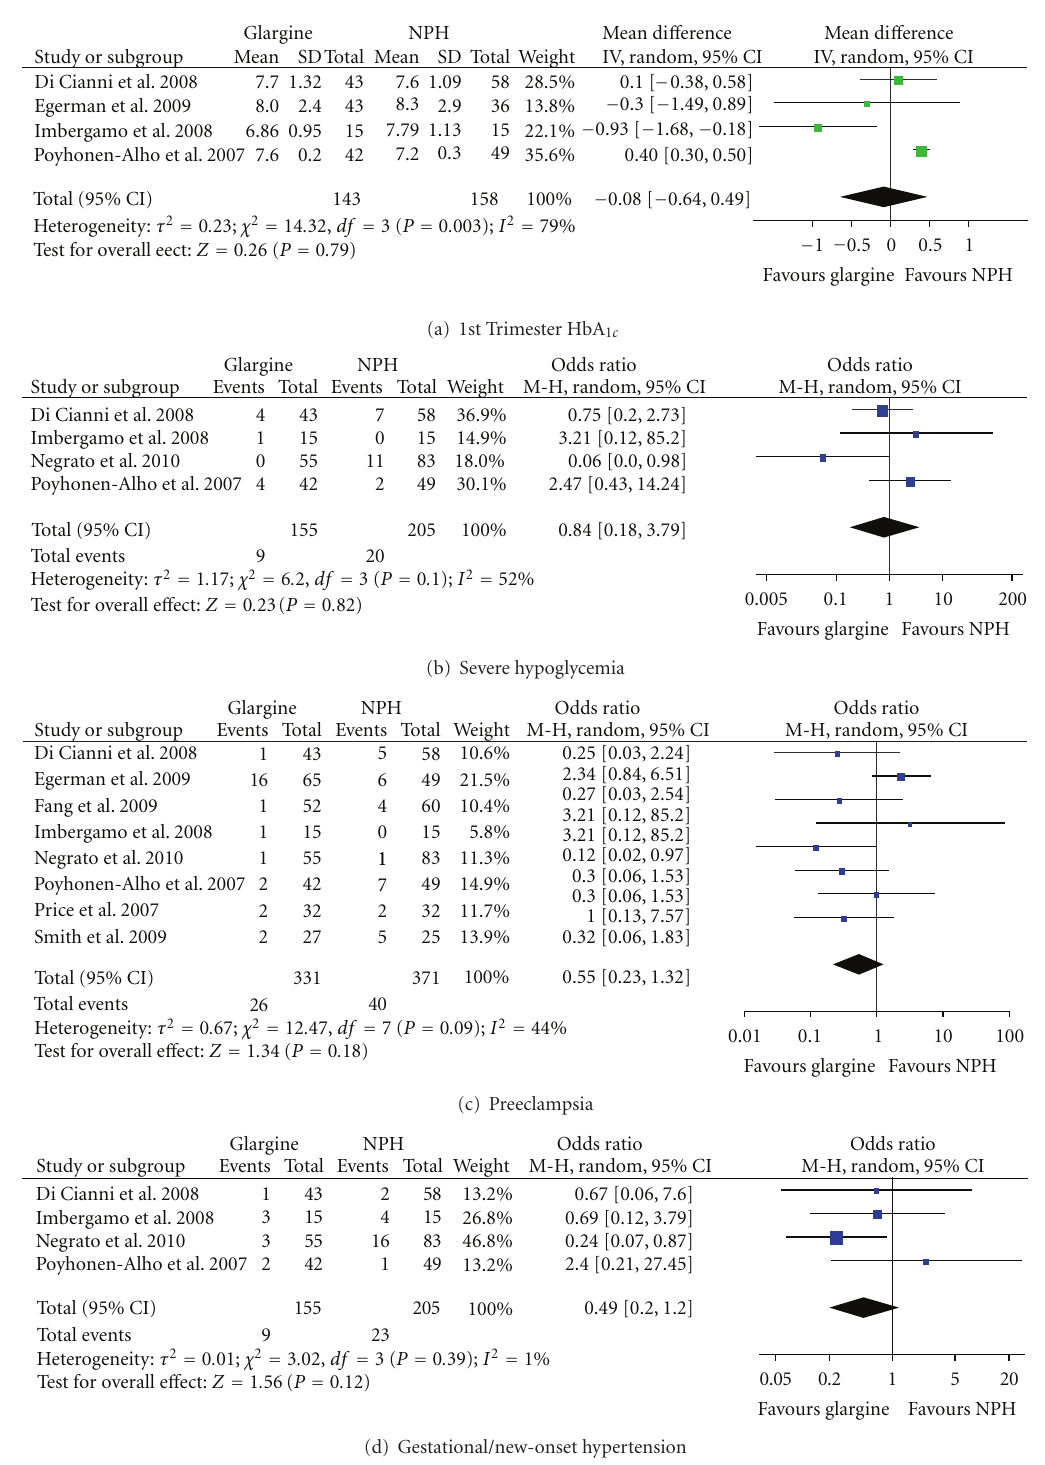
Figure 2: Meta-analysis results for maternal